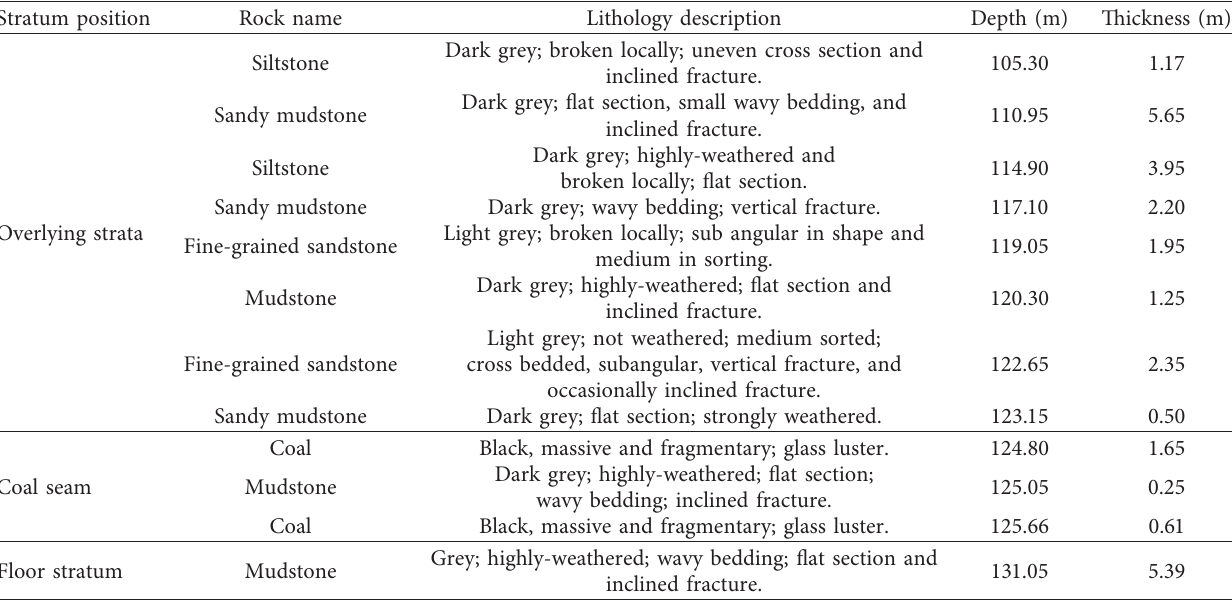
Table 2: The lithological characteristics of the